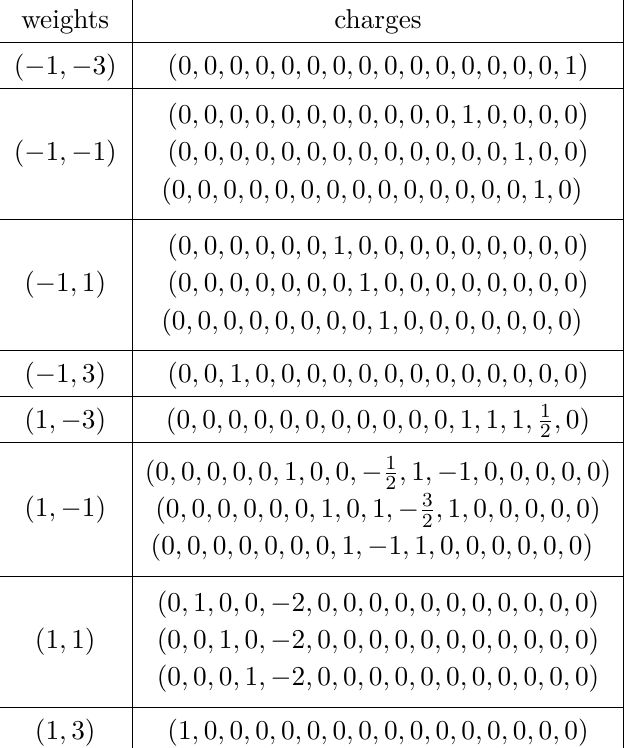
under N 0 together as ( ‘ + ‘ + ‘ ) . α L , ‘ 0 1 2 α